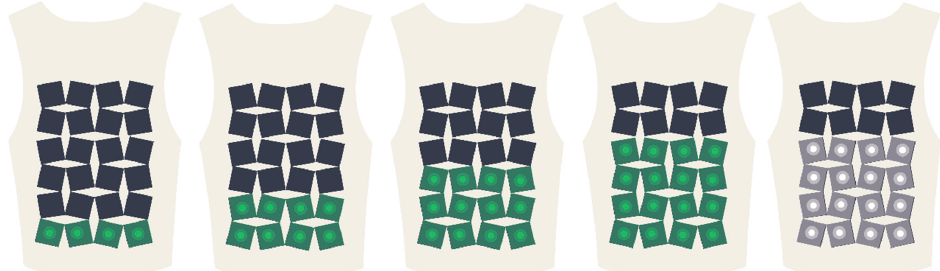
Figure 4. The LED-matrix showing an increase in the lighted rows that indicate the feedback on performance regarding the position of the breath. The white light informs the child that the rhythm was not good.